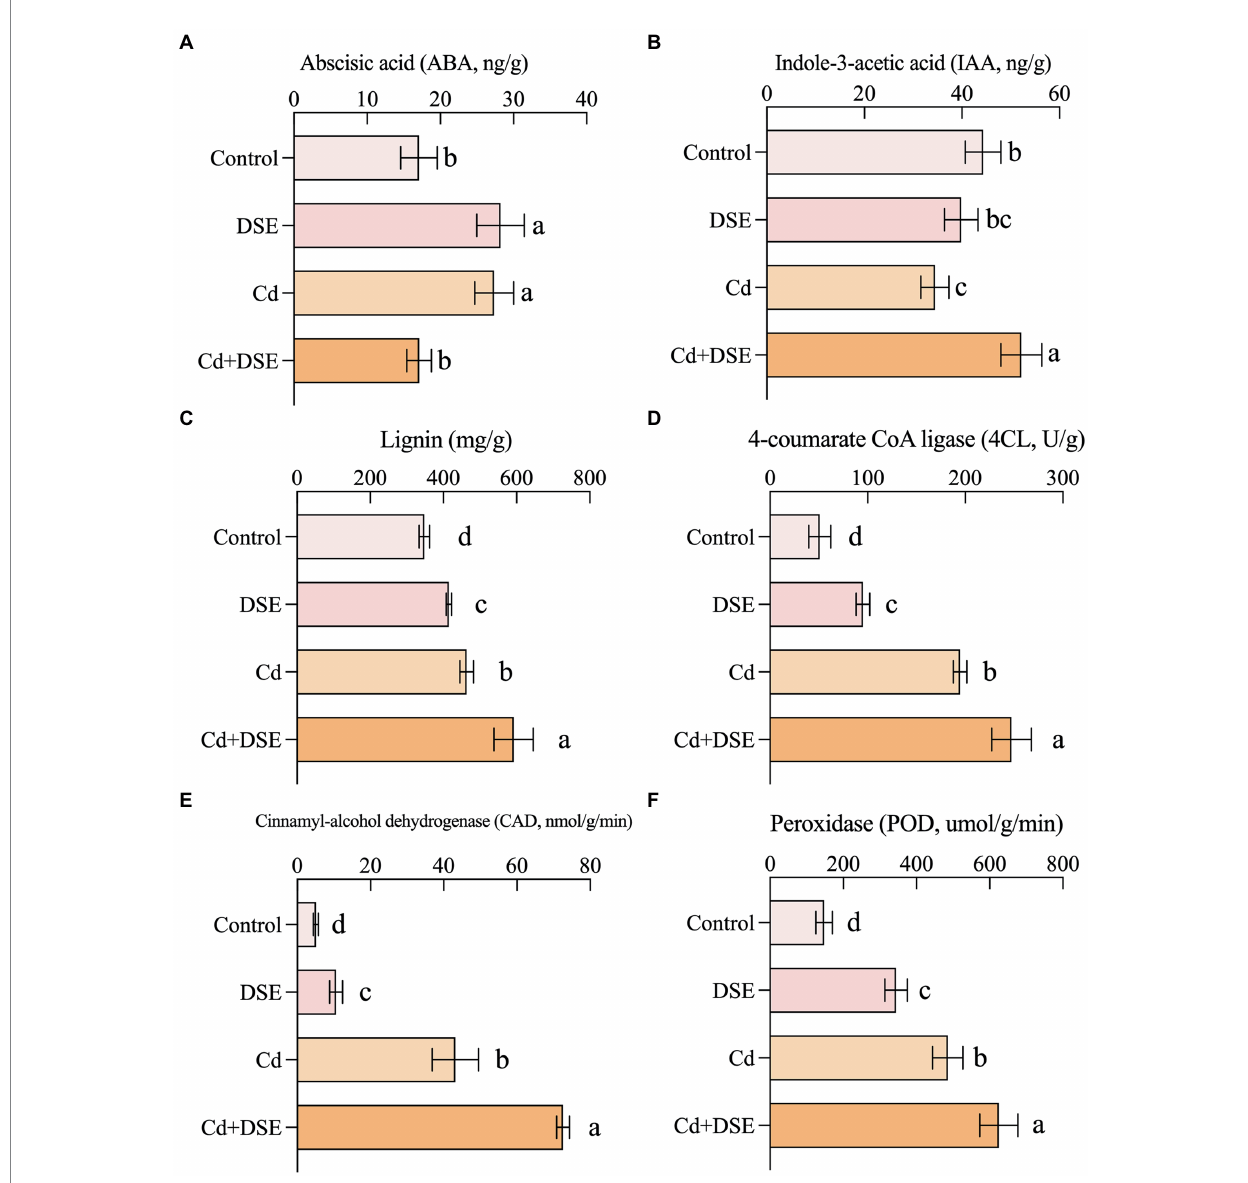
FIGURE 3 Responses of phytohormone and lignin contents and related enzyme activities of maize roots to E. pisciphila inoculation and Cd stress. A : abscisic acid, B : Indole-3-acetic acid, C : Lignin; D : 4-coumarate CoA ligase, E : Cinnamyl-alcohol dehydrogenase, F : Peroxidase. Data were mean values ( n = 3) and error bars represent the standard deviation. Different letters indicate significant differences between